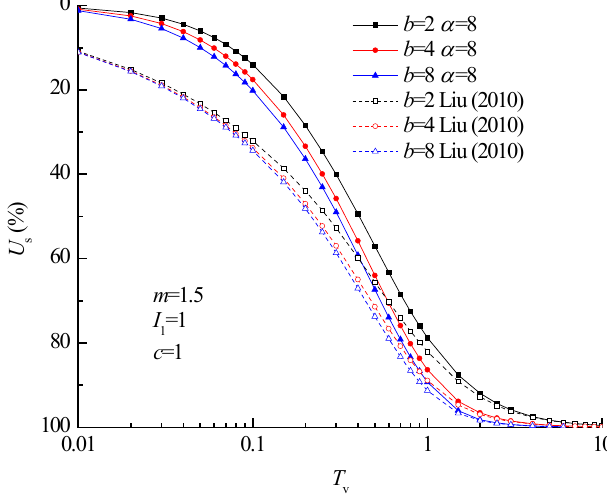
Figure 10. Influence of the b value on ACDS ( m = 1.5, c = 1) [23]. 1.5 c = 1.5 m = . The ACD obtained by the